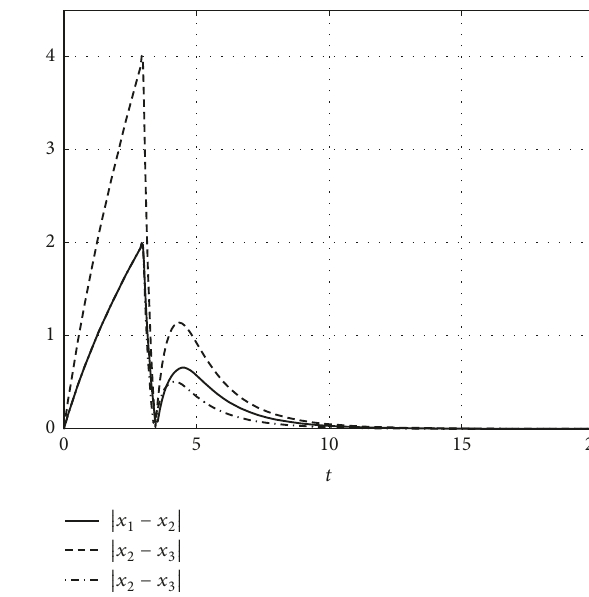
Figure 10: No-linear case, 𝑗 = 1 .